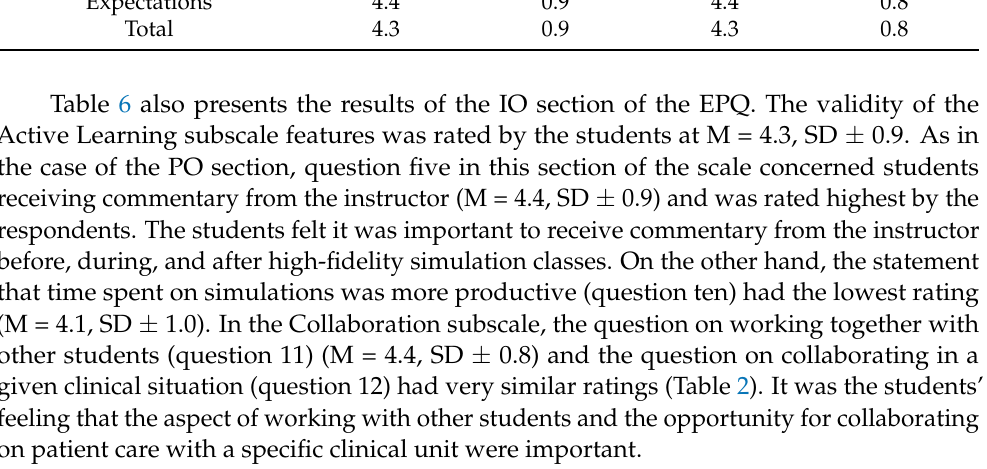
Table 6. Results for the EPQ PO and EPQ IO subscales. EPQ PO EPQ IO M SD M SD Active Learning 4.3 0.9 4.3 0.9 Collaboration 4.5 0.9 4.5 0.8 Diverse Learning Methods 4.2 0.9 4.2 0.9 Expectations 4.4 0.9 4.4 0.8 Total 4.3 0.9 4.3